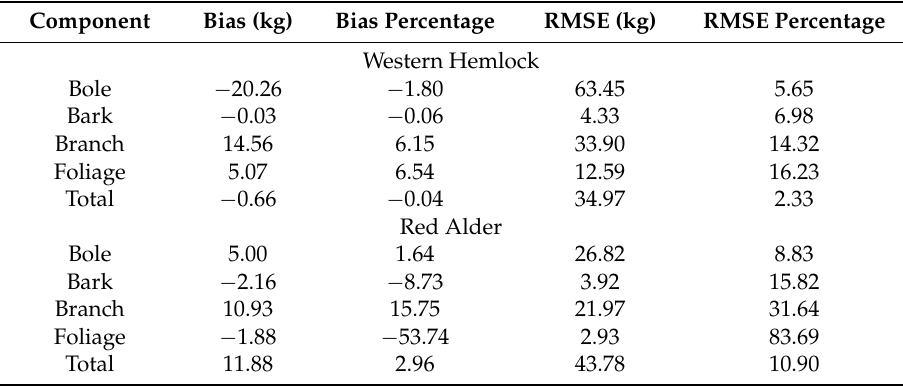
Table 3. Evaluation statistics (bias, bias percent, root mean square error (RMSE), and RMSE percent) in component biomass estimation in Western hemlock and red alder trees using seemingly unrelated regression (SUR).